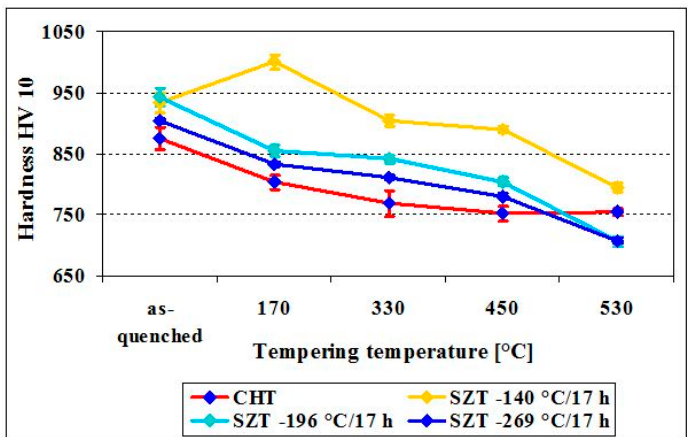
Figure 6. Hardness of CHT and differently SZT specimens made of Vanadis 6 steel in dependence on tempering temperature.